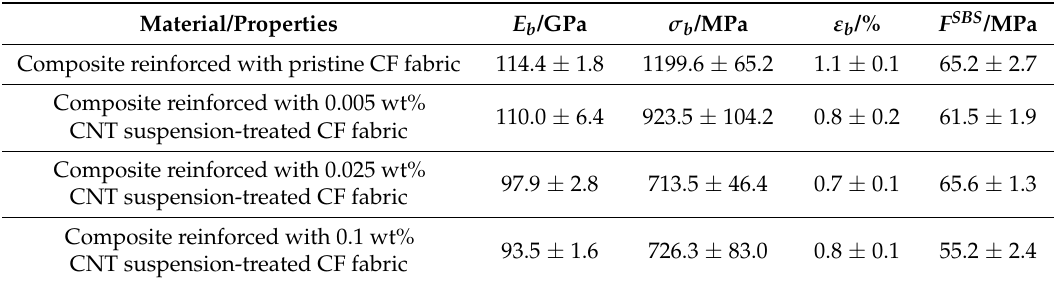
Table 1. Flexural properties and interlaminar shear strength of composites reinforced with pristine CF fabric and CNT-deposited CF fabric (ultrasonication was not used during the continuous EPD process).